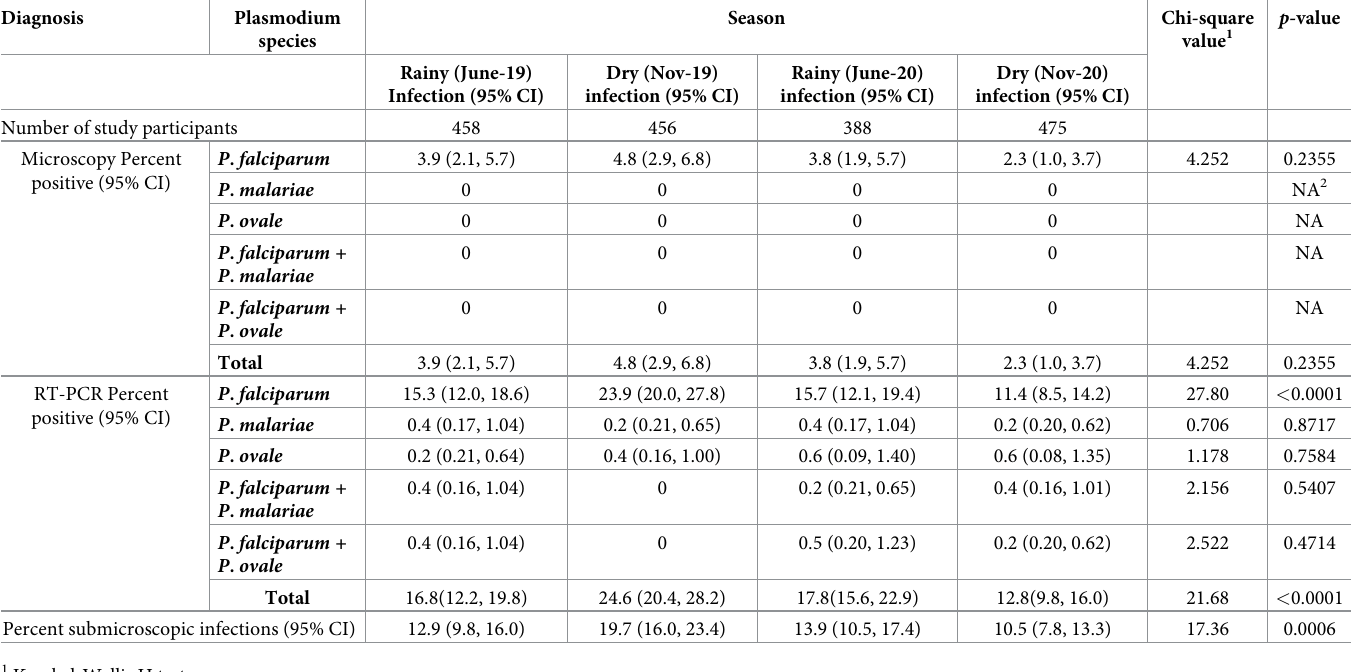
Table 2. Plasmodium infection prevalence according to season and diagnostic